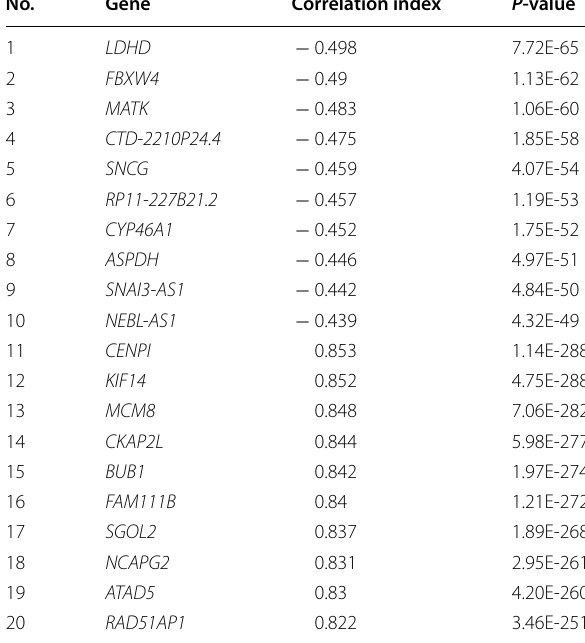
Table 4 Small molecules screened from CMap